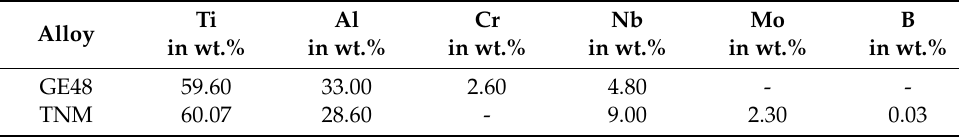
Table 1. Chemical composition of GE48 and TNM powder.